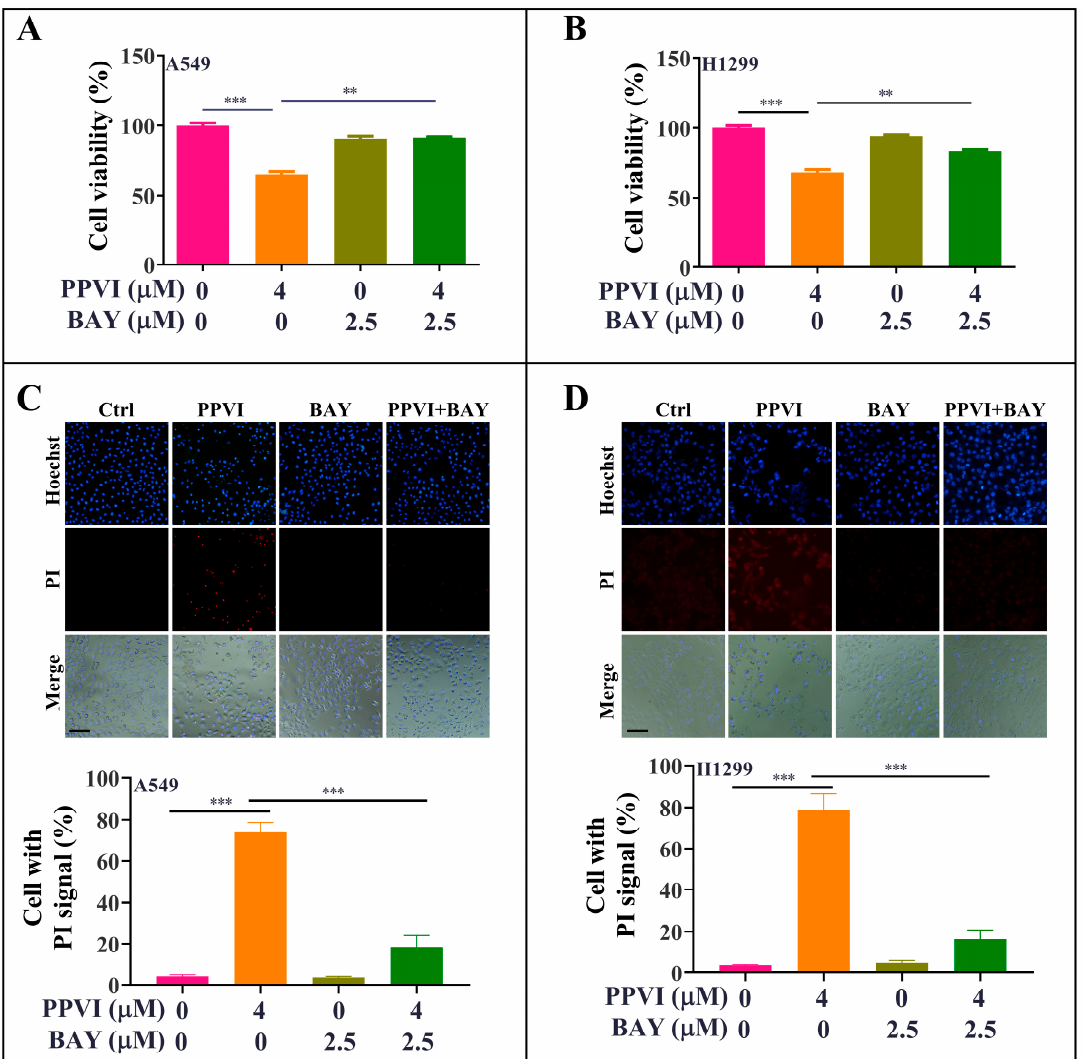
Figure 10. BAY-inhibited, PPVI-induced pyroptotic cell death in A549 cells and H1299 cells. A549 cells ( A ) and H1299 cells ( B ) treated with PPVI or co-treated with PPVI and BAY at the indicated concentration for 24 h. After treatment, the cytotoxicity was measured by MTT method, and the bar chart indicates the cell viability of A549 and H1299 cells; bars, S.D. ** p ≤ 0.01; *** p ≤ 0.001. A549 cells ( C ) and H1299 cells ( D ) treated with PPVI or co-treated with PPVI and BAY at the indicated concentration for 24 h. The cells were then stained with 2 µg/mL PI (red, staining dying cells) plus 2 µg/mL Hoechst 33342 (blue, staining all cells) for 10 min, and then observed by fluorescent microscopy. Bar chart indicates the percentage of cells with PI signal compared to blue signal; bars, S.D. *** p ≤ 0.001. Magnification: 10×, Scale bar: 100 µm.